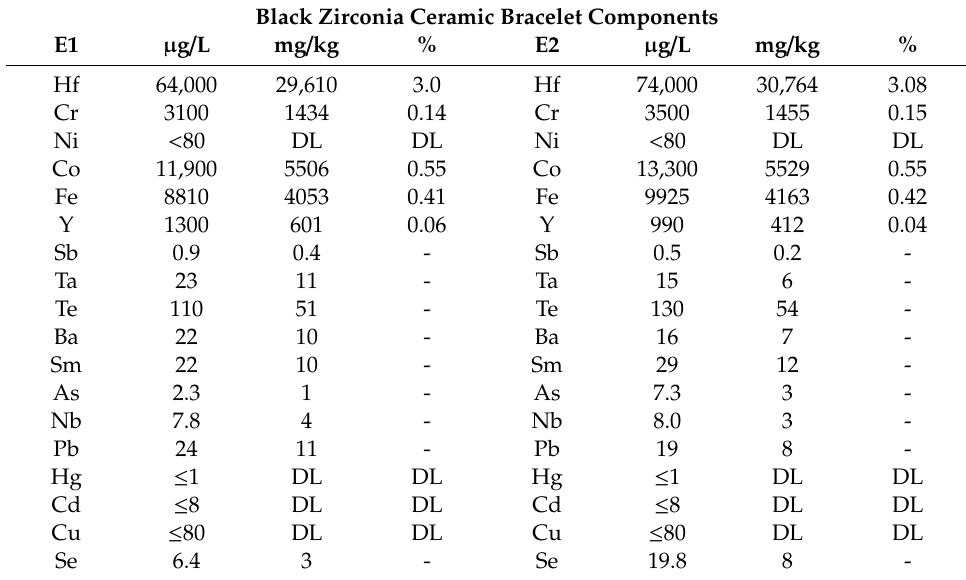
Figure 18. Concentration of elements Cr, Ni, Co and Y [ mg/kg ] found in solution.